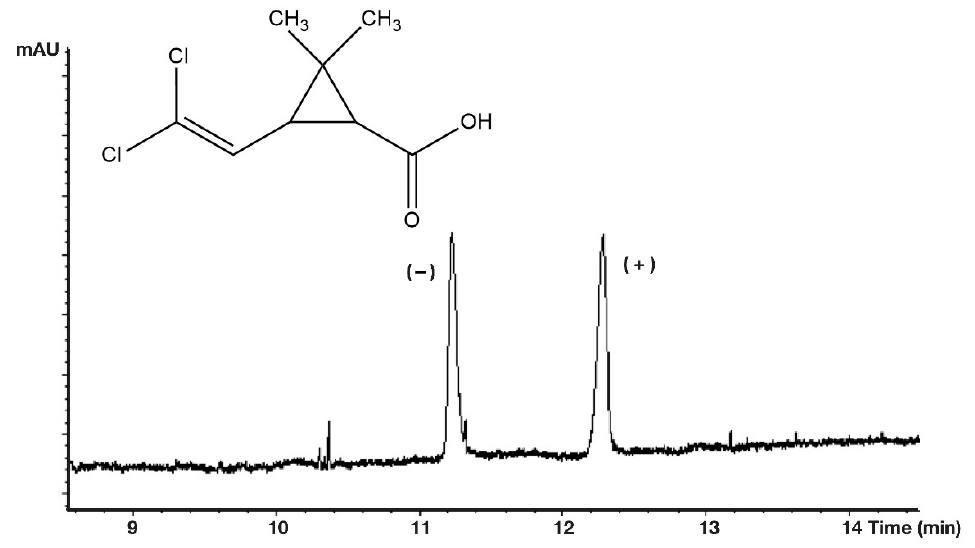
Figure 9. Chiral separation of cis -permethrinic acid enantiomers. Conditions: instrument, 50/58.5 cm silica-fused capillary; buffer, 50 mM phosphate buffer, pH 4.5; potential, 30 kV; temp, 25 °C; UV, 214 nm; selector, 10 mM PMMA β CD [19].